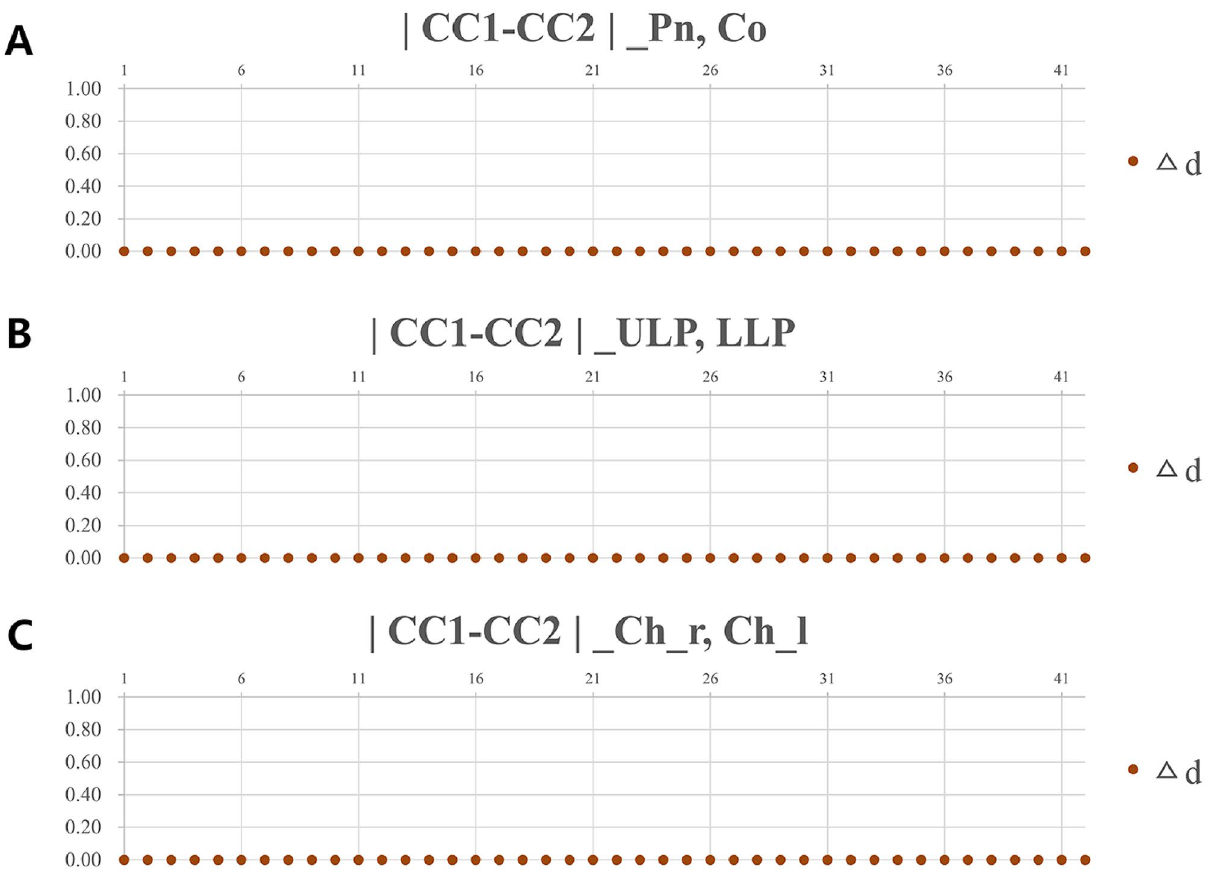
Figure 6. The differences in CC points of the 3D soft tissue landmarks using 42 samples derived from each examiner. ( A ) Pronasale and columella. ( B ) Upper lip and lower lip. ( C ) Cheek right and cheek left. CC1, CC point from examiner 1; CC2, CC point from examiner 2; Δd, difference of distances between CC1 and